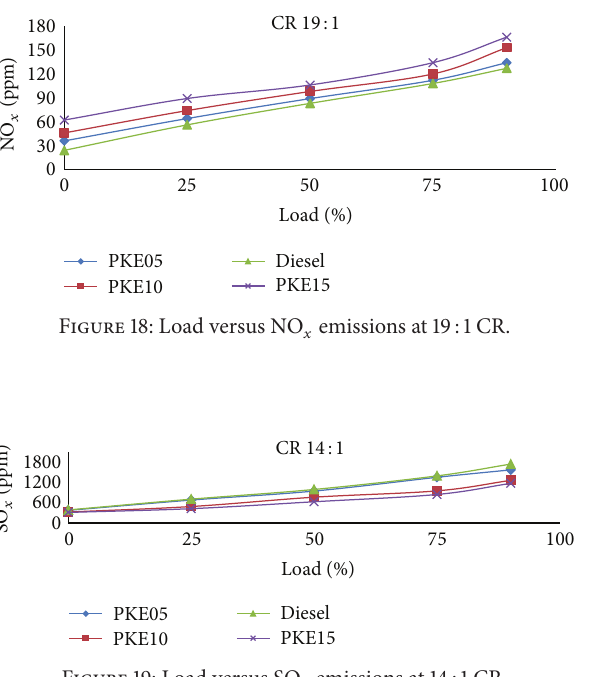
Figure 21: Load versus SO 𝑥 emissions at 19 :1